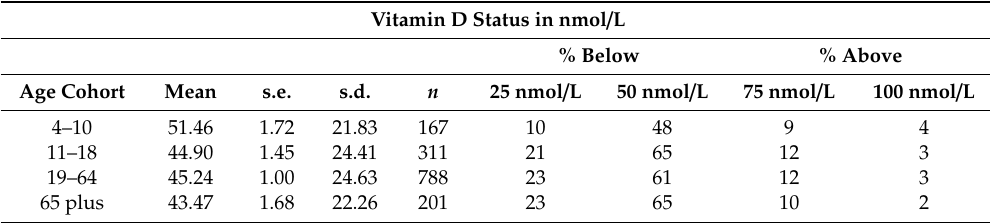
Table 2. Vitamin status (25 hydroxy vitamin D serum concentrations (nmol / L)) in the various age cohorts with males and females combined, data from the NDNS database before application of the model. Vitamin D Status in nmol / L % Below % Above Age Cohort